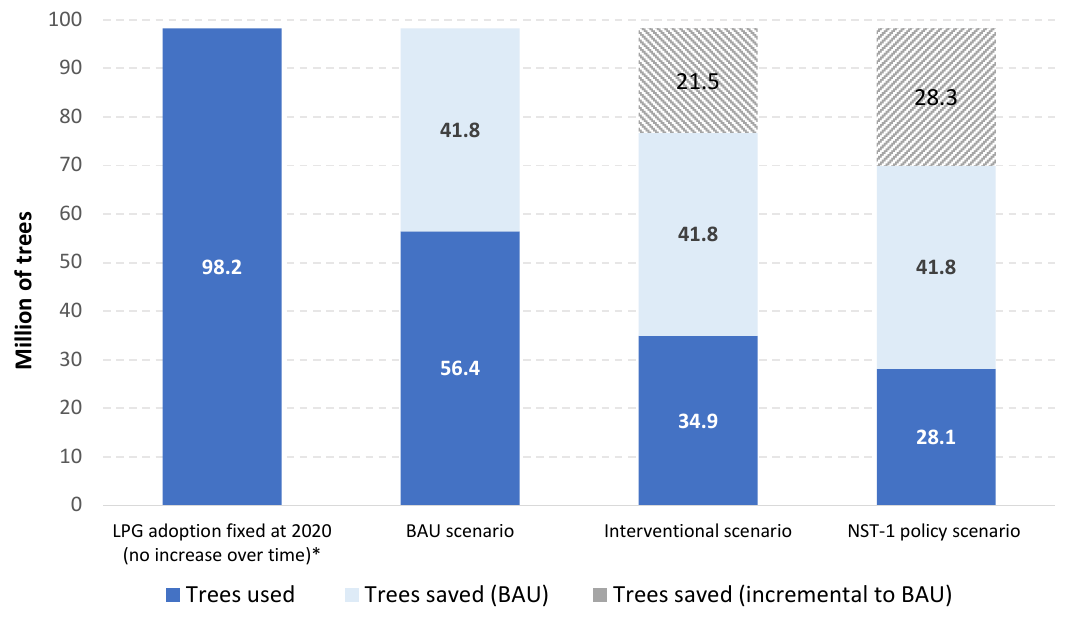
Figure 4. Number of trees saved due to reduction in solid fuel use from LPG adoption in 2030 per each of the scenarios.